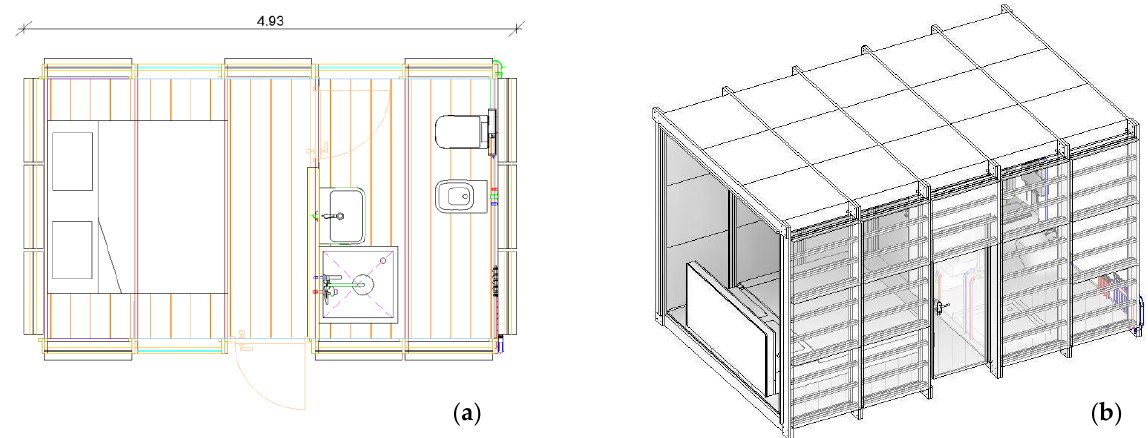
Figure 3. Plan layout of the basic Sustanzeb module ( a ). A 3D view of the basic Sustanzeb module ( b ).